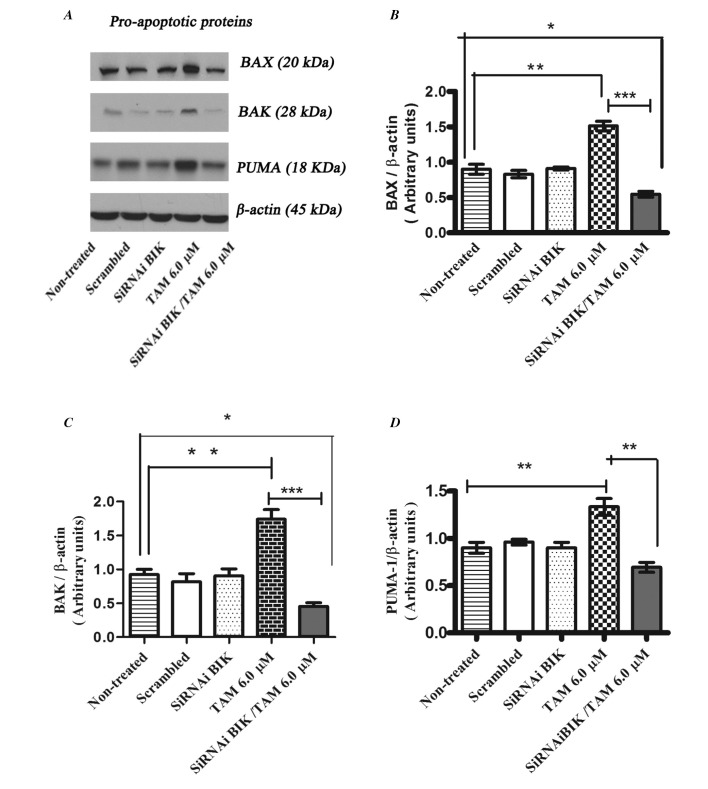
Suppression of BIK regulated negatively pro-apoptotic proteins in MCF-7 cells treated with TAM. (A) MCF-7 cells were incubated for 48 h, cell lysates were prepared from the cells, and subjected to western blot analyses for BAX, BAK and PUMA. One representative of at least three independent experiments with similar results is shown. (B, C and D) Band intensity in BAX, BAK and PUMA was quantified by densitometric analysis. The groups were analyzed by one-way analysis of variance (ANOVA) with the Tukey’s test. *p<0.05; **p<0.01; ***p<0.001 vs. non-treated; n.s., not significant. Representative figures of three independent experiments carried out in triplicate are shown.